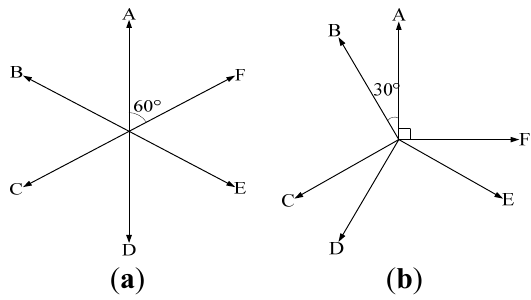
Figure 1. Two winding configurations for six-phase permanent magnet